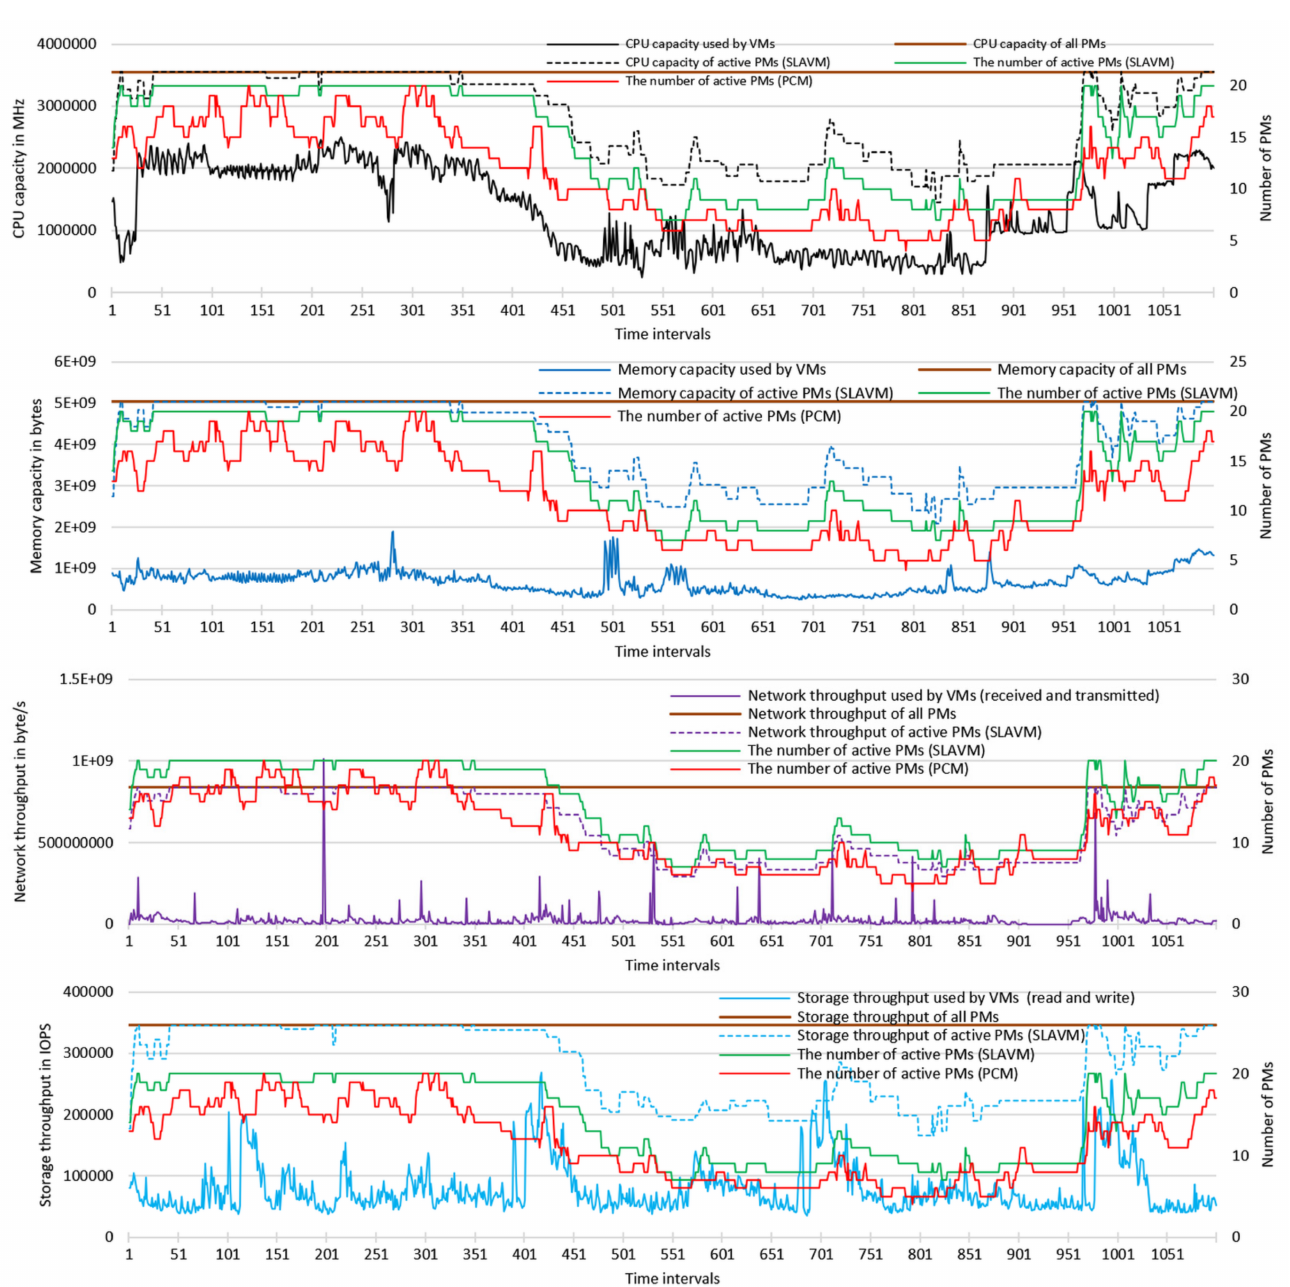
Figure 15. The results of dynamic PM management, resource utilization of active PMs, and VM workload during the simulation